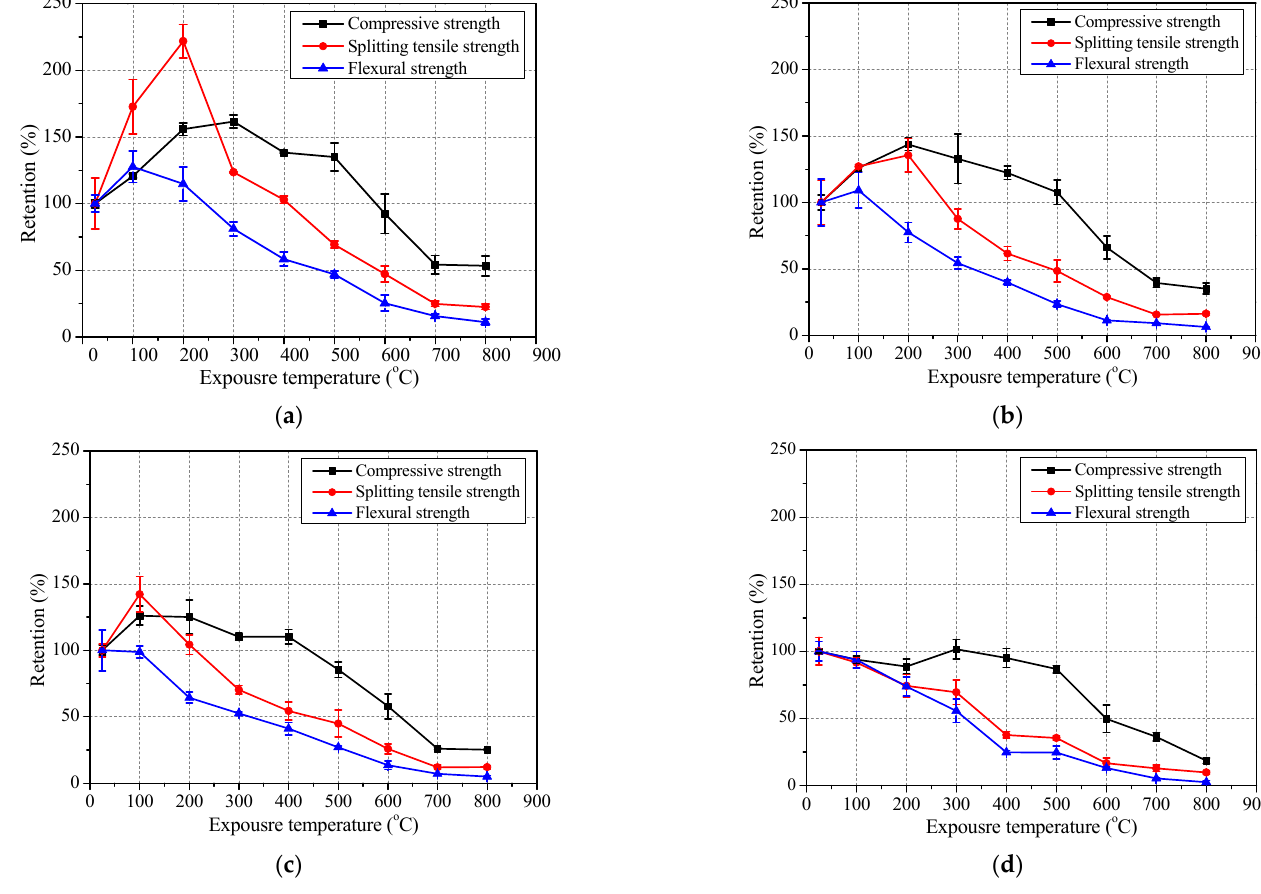
Figure 10. Comparison of compressive strength, splitting tensile strength and flexural strength retention of concrete after exposure to elevated temperature: ( a ) GC-C30; ( b ) CG-C40; ( c ) GC-C50 and ( d ) OC-C40.